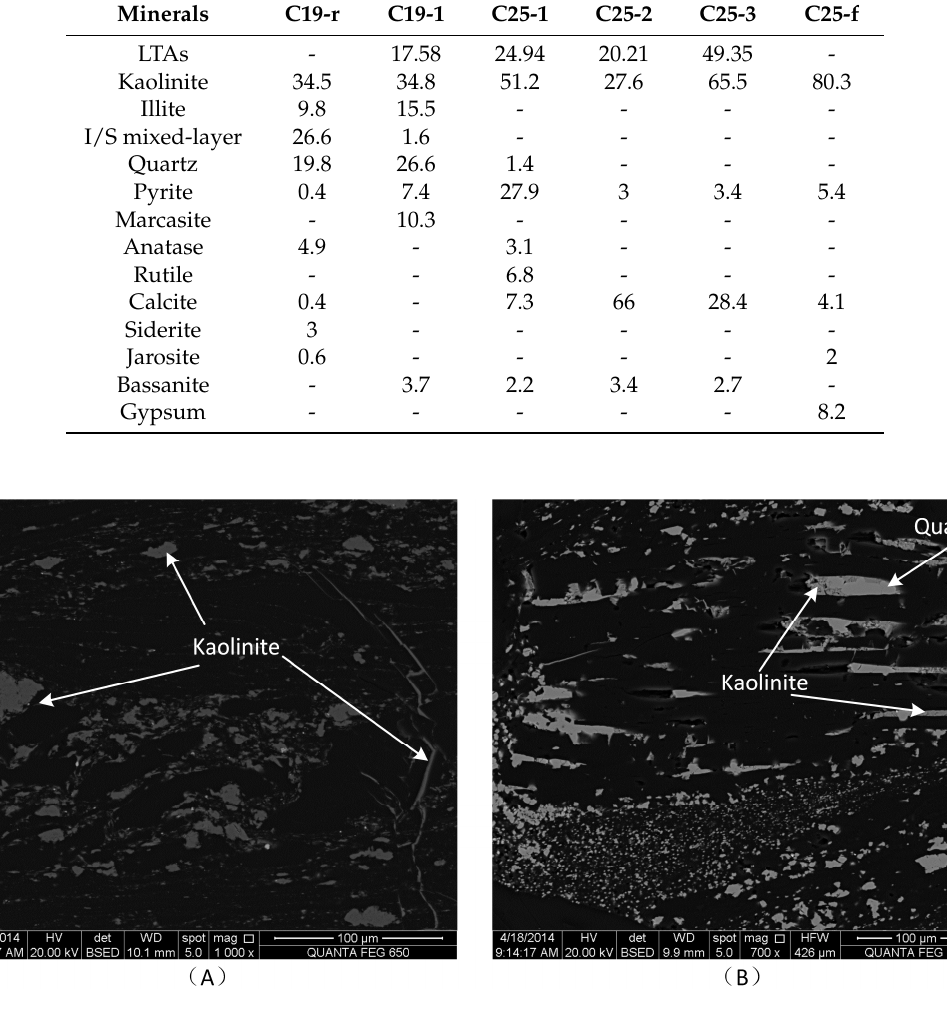
Figure 4. SEM back-scattered electron images of discrete particles and fracture-filling kaolinite in sample C19-1 ( A ); and cell-filling kaolinite and quartz in sample C25-2 ( B ).